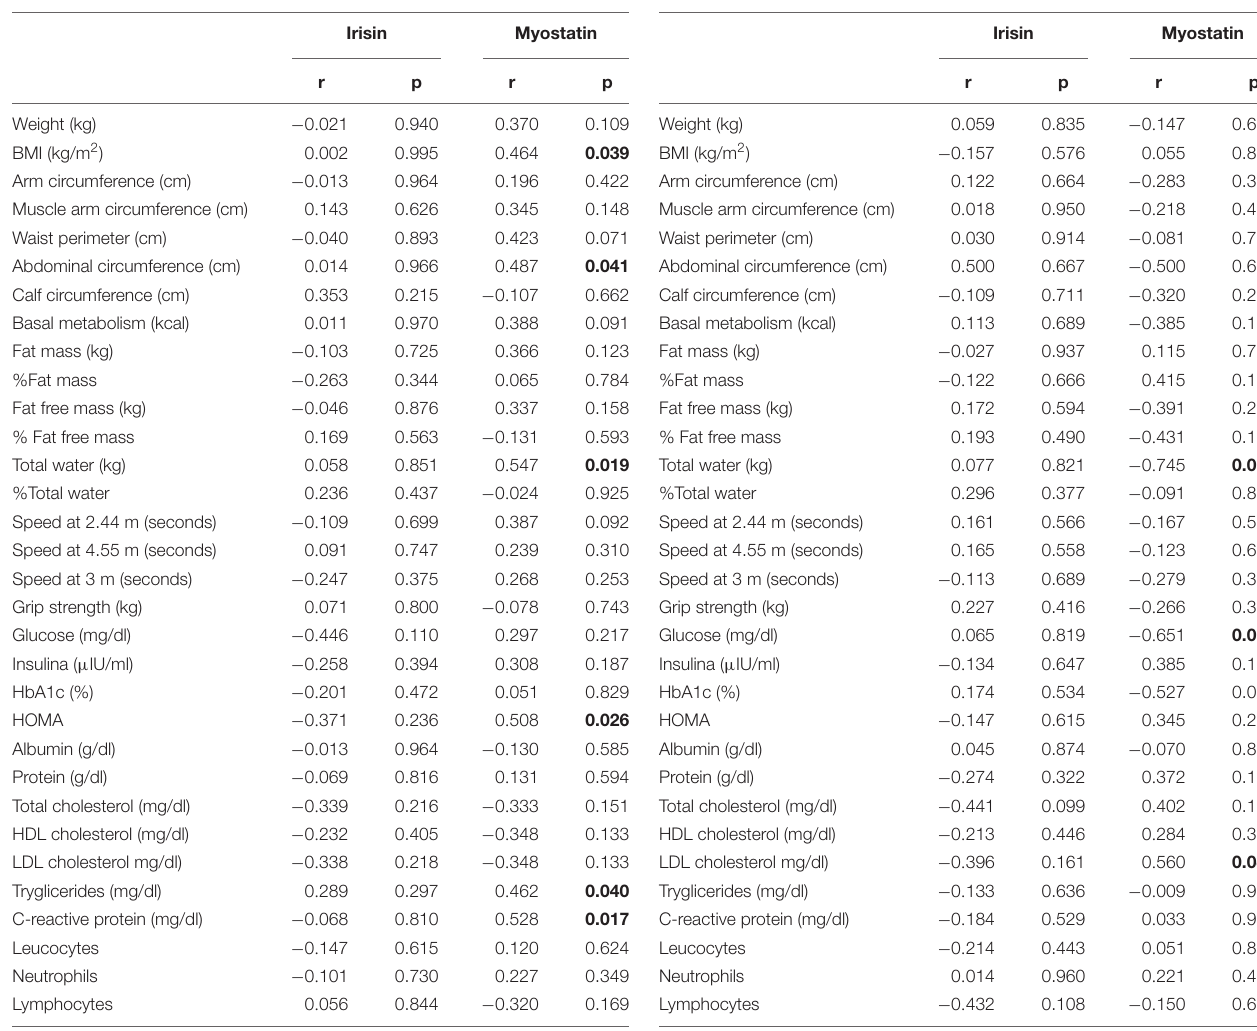
TABLE 7 | Bivariate correlations between anthropometrical and clinical parameters and circulating irisin and myostatin in resistance exercise group at